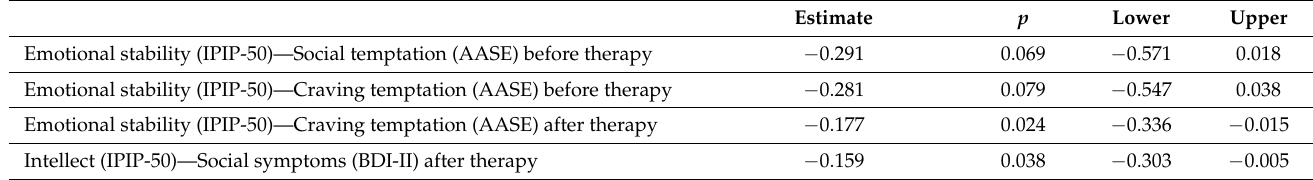
Table 5. Standardized regression weights for associations between personality and self-efficacy in the investigated group before and after therapy. Estimate p Lower Upper − 0.291